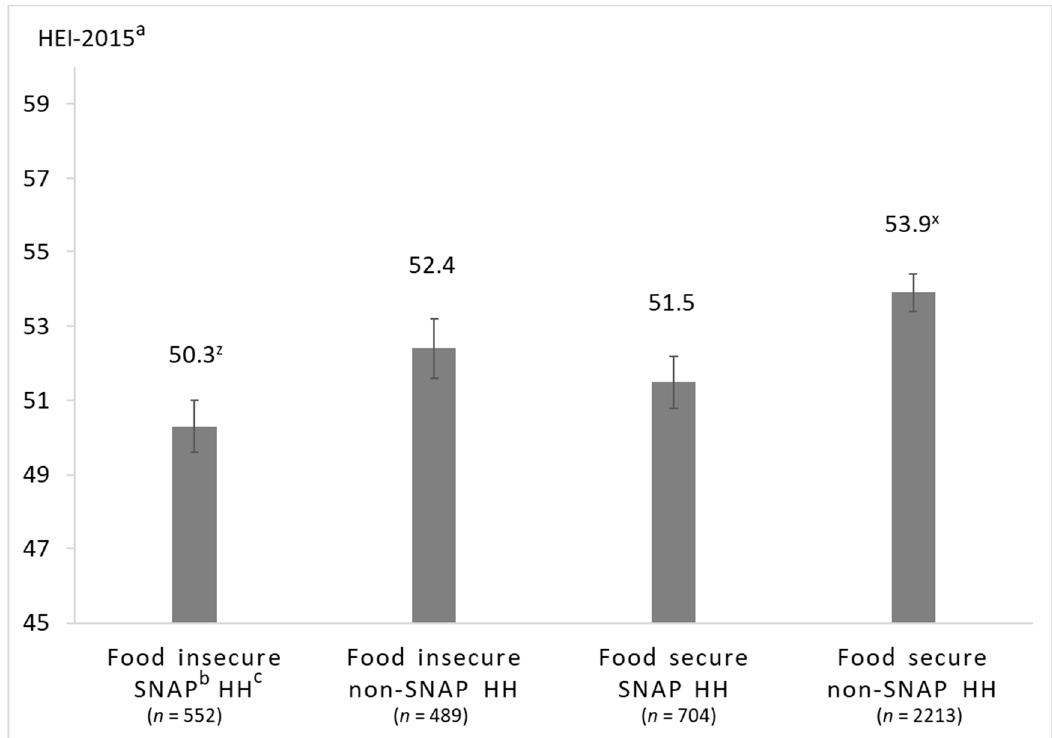
Figure 3. Multivariable-adjusted least square means of total HEI-2015 score of household